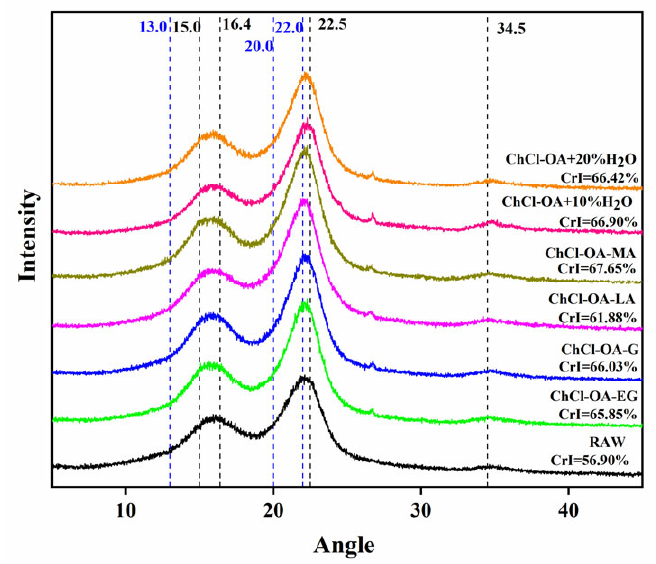
Figure 2. The X-ray diffraction (XRD) patterns of bagasse cellulose treated with different deep eutectic solvents (DESs).